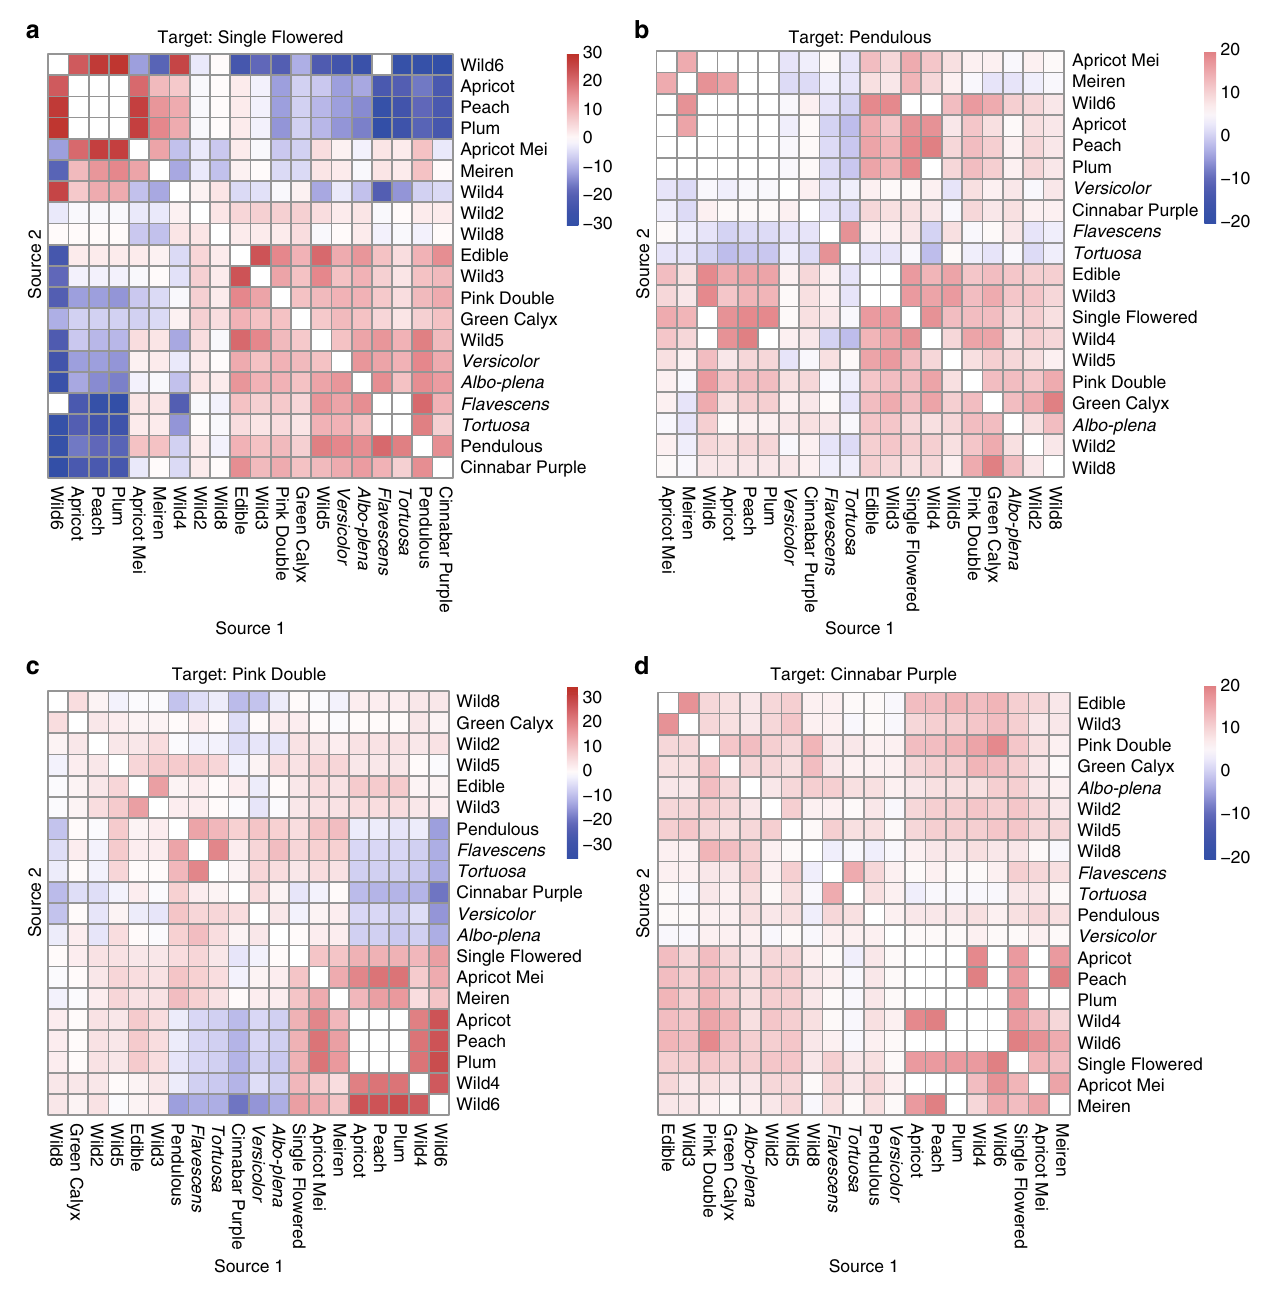
Fig. 2 Inter- and intro-species introgression in mei population. Heat maps for three-population F3 test statistics of four cultivar groups ( a – d represent Single Flowered, Pendulous, Pink Double, and Cinnabar Purple respectively) of mei. Introgression is signi fi cant if the Z -score is signi fi cantly negative ( Z - score < − 1.96, blue). Heat maps were generated using R/pheatmap package (Supplementary Table 3) indicated good quality of the method. Assembly of the genome from each sequenced accession resulted in an average contig N50 of ~15.5 kb and scaffold N50 of ~22.6 kb, respectively (Table 1, Supplementary Table 4). An average of 25,839 genes were annotated per genome, which accounted for 82.32% of the mei reference genome (31,390 genes in total, Table 1 and Supplementary Table 5). Assembly-based accessions, and 2.85 – 3.38 million SNPs among the other sequenced Prunus genomes (Supplementary Table 5). A low but consistent SNP frequency might suggest a low rate of divergence during the domestication of mei.